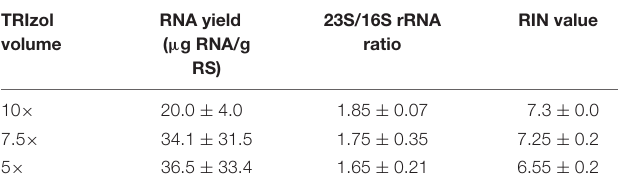
∗ Data represents mean and standard error for at least 3 replicates per